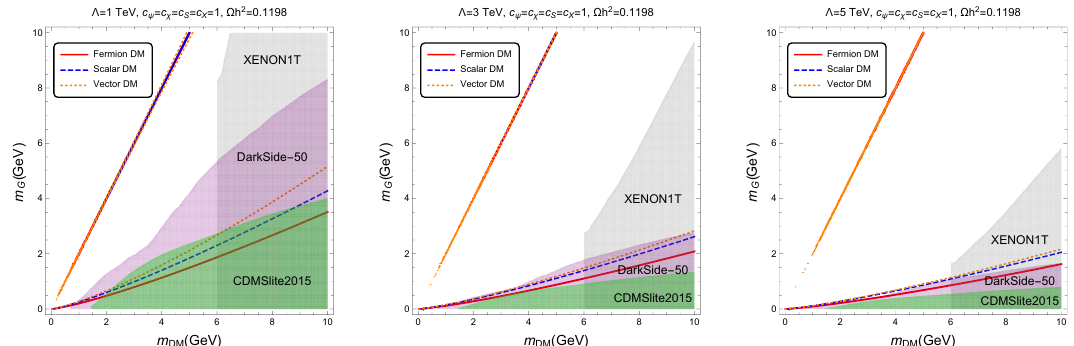
Figure 10 . Parameter space of light dark matter below 10 GeV. The gray, green and purple regions are excluded by XENON1T, CDMSlite and DarkSide-50, respectively. We took (cid:3) = 1 ; 3 ; 5 TeV on left, middle and right, respectively. The other parameters are the same as in (cid:12)gure 6. that those from other experiments, so we don’t show them in (cid:12)gure 10. We have